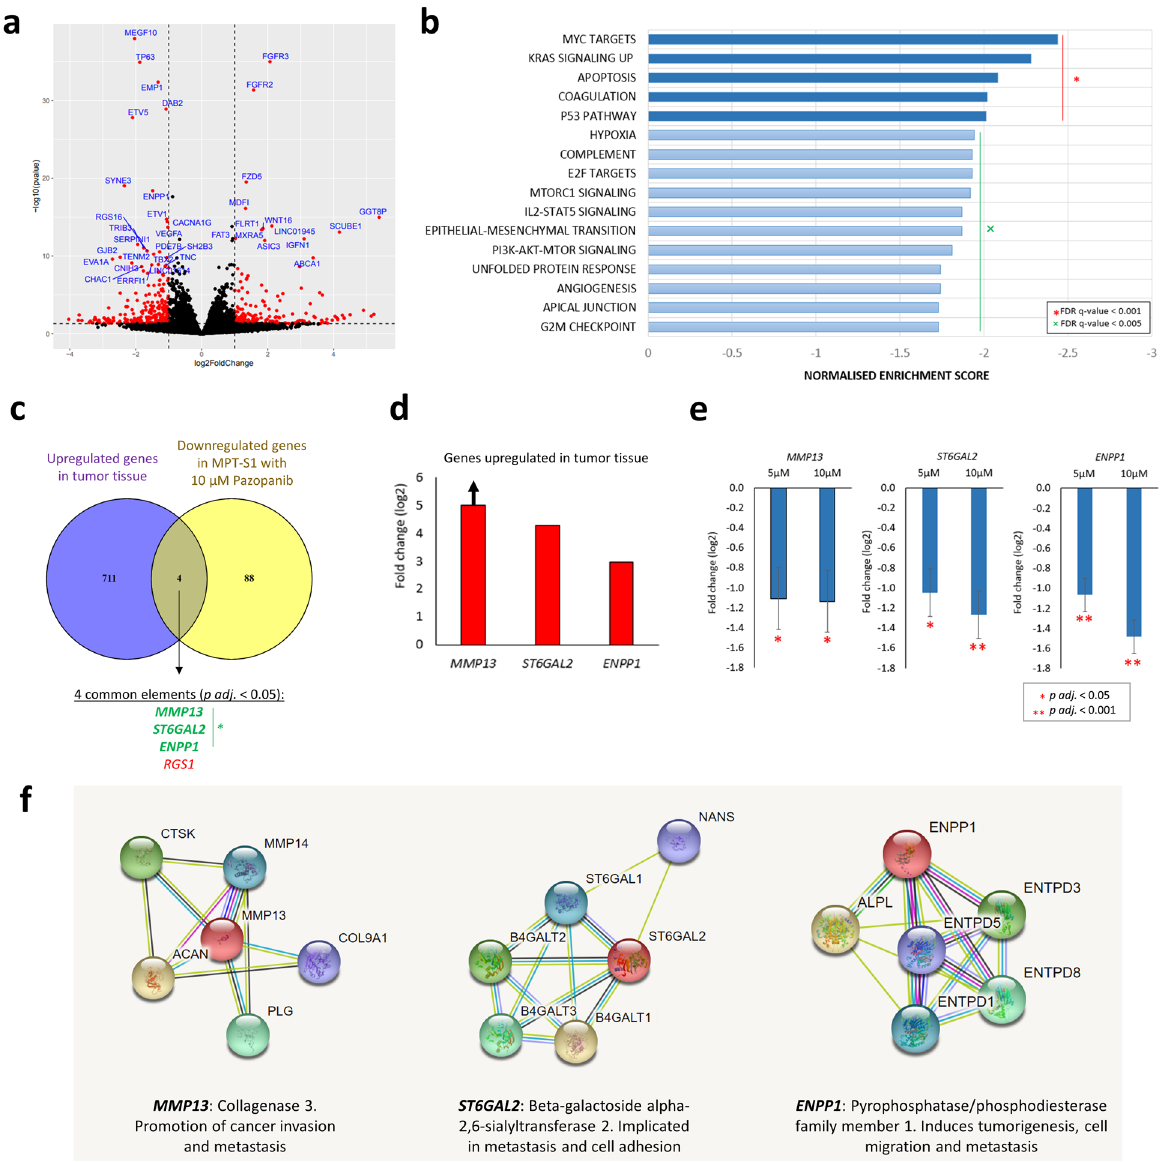
Fig. 4 Downregulation of genes involved in oncogenic and apoptosis signaling pathways by pazopanib. a Volcano plot showing signi fi cant differentially-expressed genes after treatment of MPT-S1 cell line with pazopanib (10 µM). b Gene set enrichment analysis highlighted top-scoring downregulated gene sets in oncogenic and apoptosis signaling pathways. c Overlap of upregulated genes in the tumor tissue and downregulated genes in the cell line by pazopanib identi fi ed genes involved in cancer invasion and metastasis ( MMP13 , ST6GAL2 , and ENPP1). d MMP13 , ST6GAL2 , and ENPP1 genes are upregulated in tumor tissue compared to adjacent normal tissue. e Downregulation of MMP13 , ST6GAL2, and ENPP1 in the cell line following treatment with pazopanib. f Protein interaction network of MMP13, ST6GAL2, and ENPP1 and their putative role in cancer